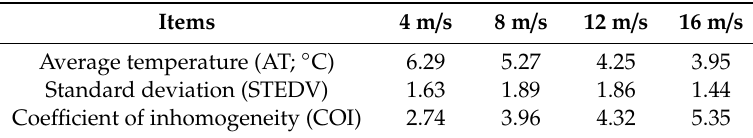
Table 3. Analysis results of di ff erent parameters.